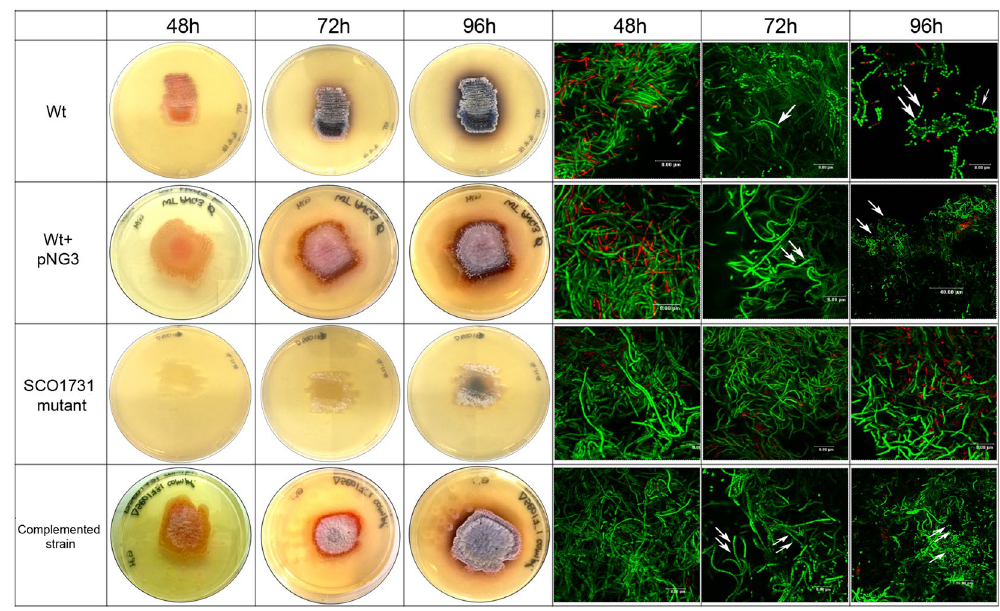
Figure 6. Morphological differentiation of the S . coelicolor wild-type strain, the SCO1731::Tn5062 mutant and the SCO1731::Tn5062 complemented strain on GYM plates. Macroscopic view (left panels); CLSM images (right panels) taken after staining the cells with the LIVE/DEAD Bac-Light bacterial viability kit. Arrows indicate spore chains.